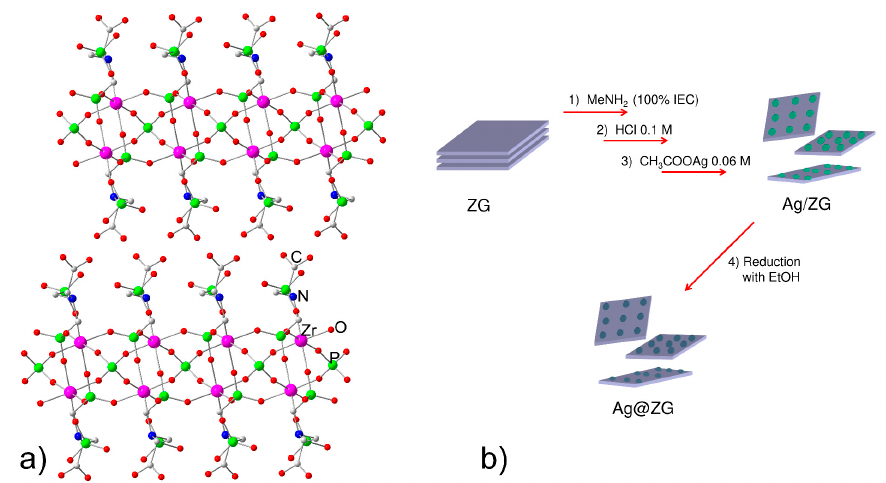
Figure 1. a ) Schematic representation of the structure of zirconium phosphate glycine-N,N- bismethylphosphonate (ZG); b ) Synthetic procedure used to prepare Ag@ZG.